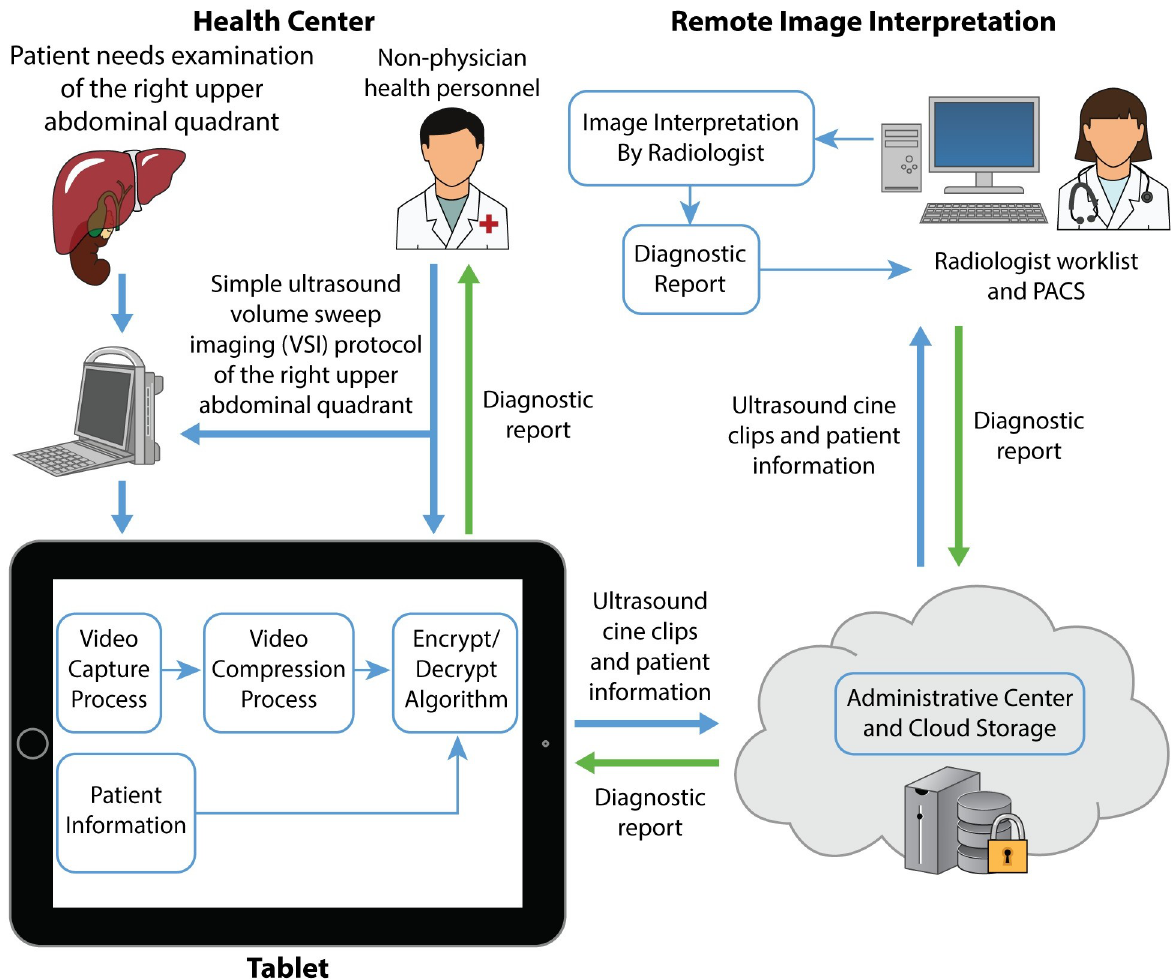
Fig 1. Overview of the RUQ telediagnostic ultrasound system. Imaging information of the right upper abdominal quadrant is acquired by health personnel of any skill level and is sent through the tablet from the health center for remote imaging interpretation (blue arrows). A diagnostic report is returned to the health center for the health personnel and patient (green